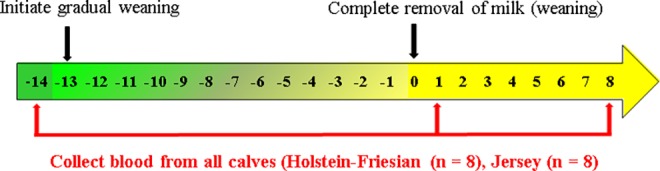
Illustration of the animal model, specifically the days relative to weaning and the days the calves were blood-sampled relative to weaning.The arrow contains day numbers relative to weaning. The first black arrow shows that gradual weaning was initiated on day -13. The second black arrow represents weaning when milk was removed from the diet on day 0. The red arrows show the days the calves were blood sampled relative to weaning, days -14, 1 and 8.